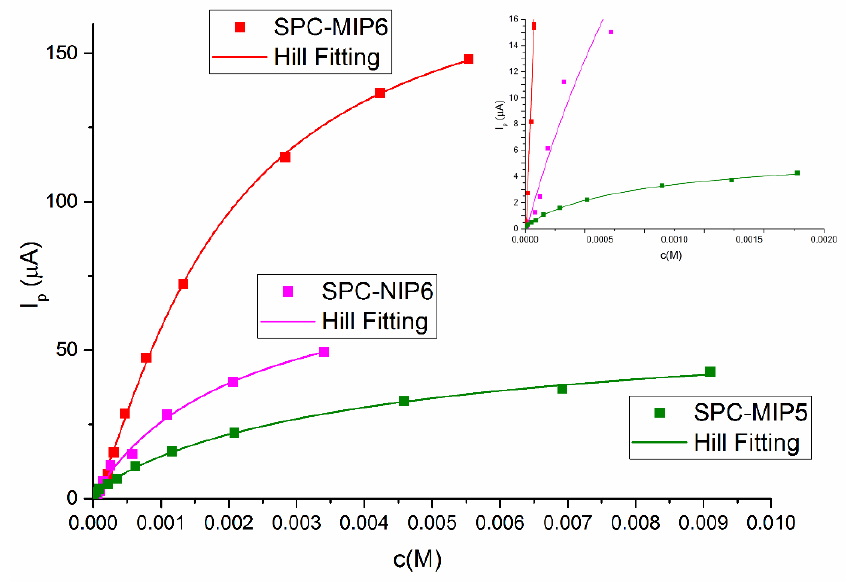
Figure 3. Voltammograms in NaCl 0.1M water solution. ( a ) bare platform, ( b ) SPC-MIP5 SWV conditions: E s = 0.01 V, E p = 0.025, f = 25 p/s.